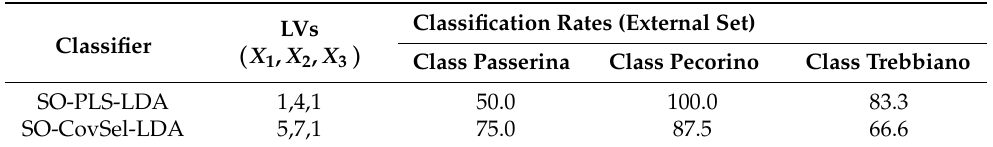
Table 3. Data-block (SO-PLS-DA and SO-CovSel-LDA) models: number of latent variables (LVs) for each block and classification rate on the external prediction set.